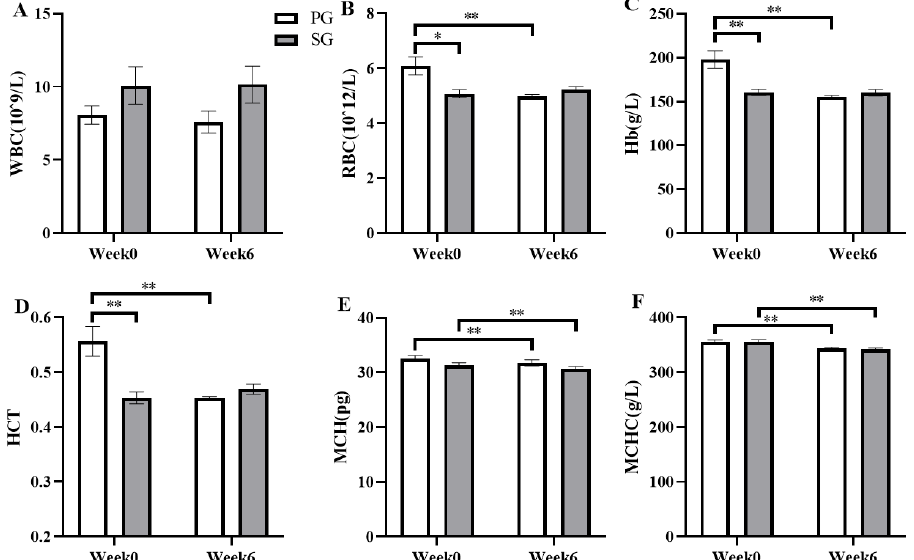
Figure 6. Comparison of the effects of the prebiotic and synbiotic on blood cell counts immediately after the constant load test in elite football players. Results are presented as mean ± SEM. PG: prebiotic group (n = 15); SG: synbiotic group (n = 15). ( A ) WBC concentration. ( B ) RBC concentration. ( C ) Hb concentration. ( D ) HCT concentration. ( E ) MCH concentration. ( F ) MCHC concentration. *: p < 0.05; **: p < 0.01.